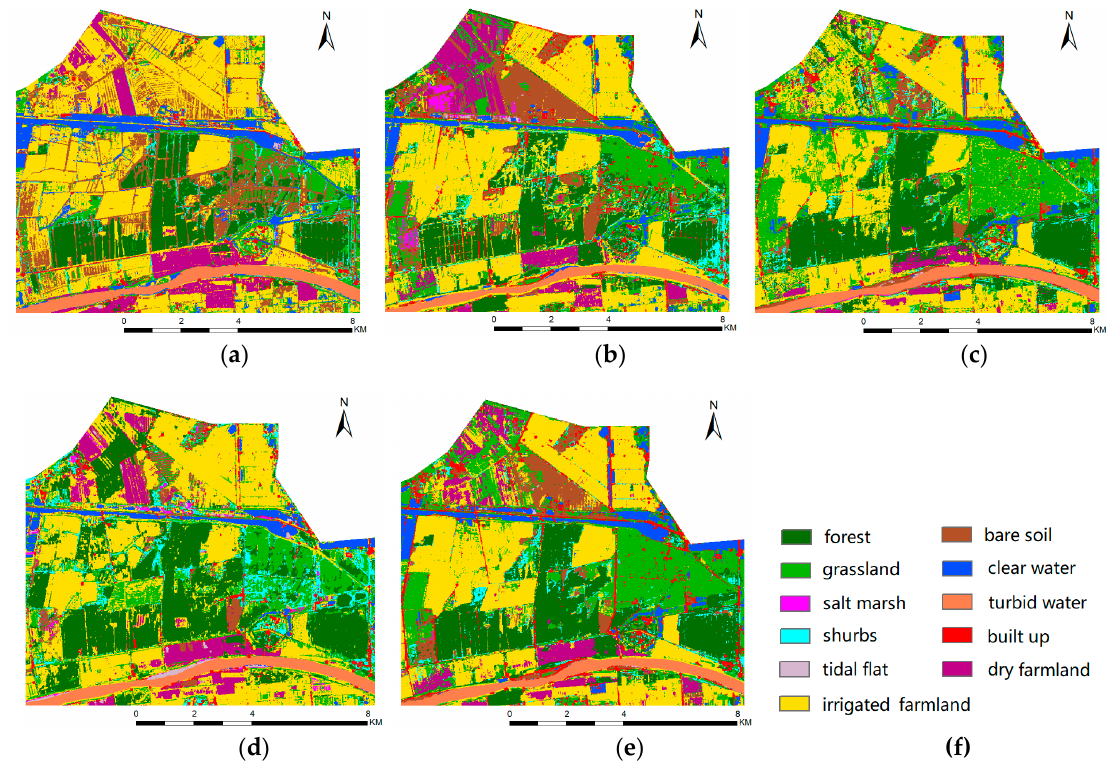
Figure 12. Details of the classification results for ( a ) T1/2018-04; ( b ) T2/2018-06; ( c ) T3/2018-08; ( d ) T4/2018-10; and ( e ) multitemporal; ( f ) legend.